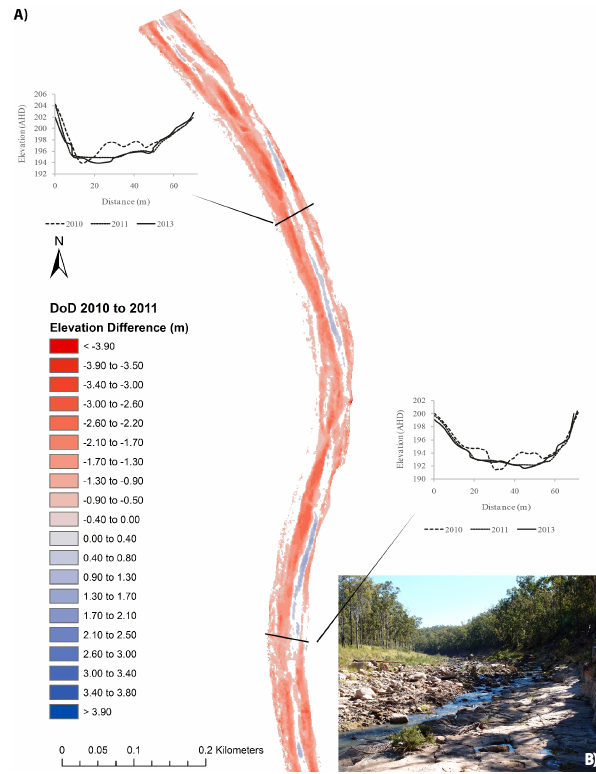
Figure 6. (a) Map of DEM of difference (DoD − min LoD = 0.44) between the 2010 and 2011 lidar data at Murphys Creek (Fig. 2), due to the 2011 flood. Positive (blue) values indicate deposition and negative (red) values indicate erosion, units in metres. Flow is from top to bottom. Insets are temporal cross sections derived from 2010 and 2011 lidar (pre- and post-2011 flood) and 2013 DGPS sur- vey data (post-2013 flood) showing the effects of the 2011 flood on channel cross-sectional area. (b) Upstream view of Murphys Creek highlighting the exposure of the bedrock straths exposed in the 2011 flood. Table 4. Cross-sectional area changes due to the 2011 flood at each of the three study reaches. Cross sections were extracted approxi- mately every channel width from the pre- and post-lidar in the three reaches (15–20 cross sections per